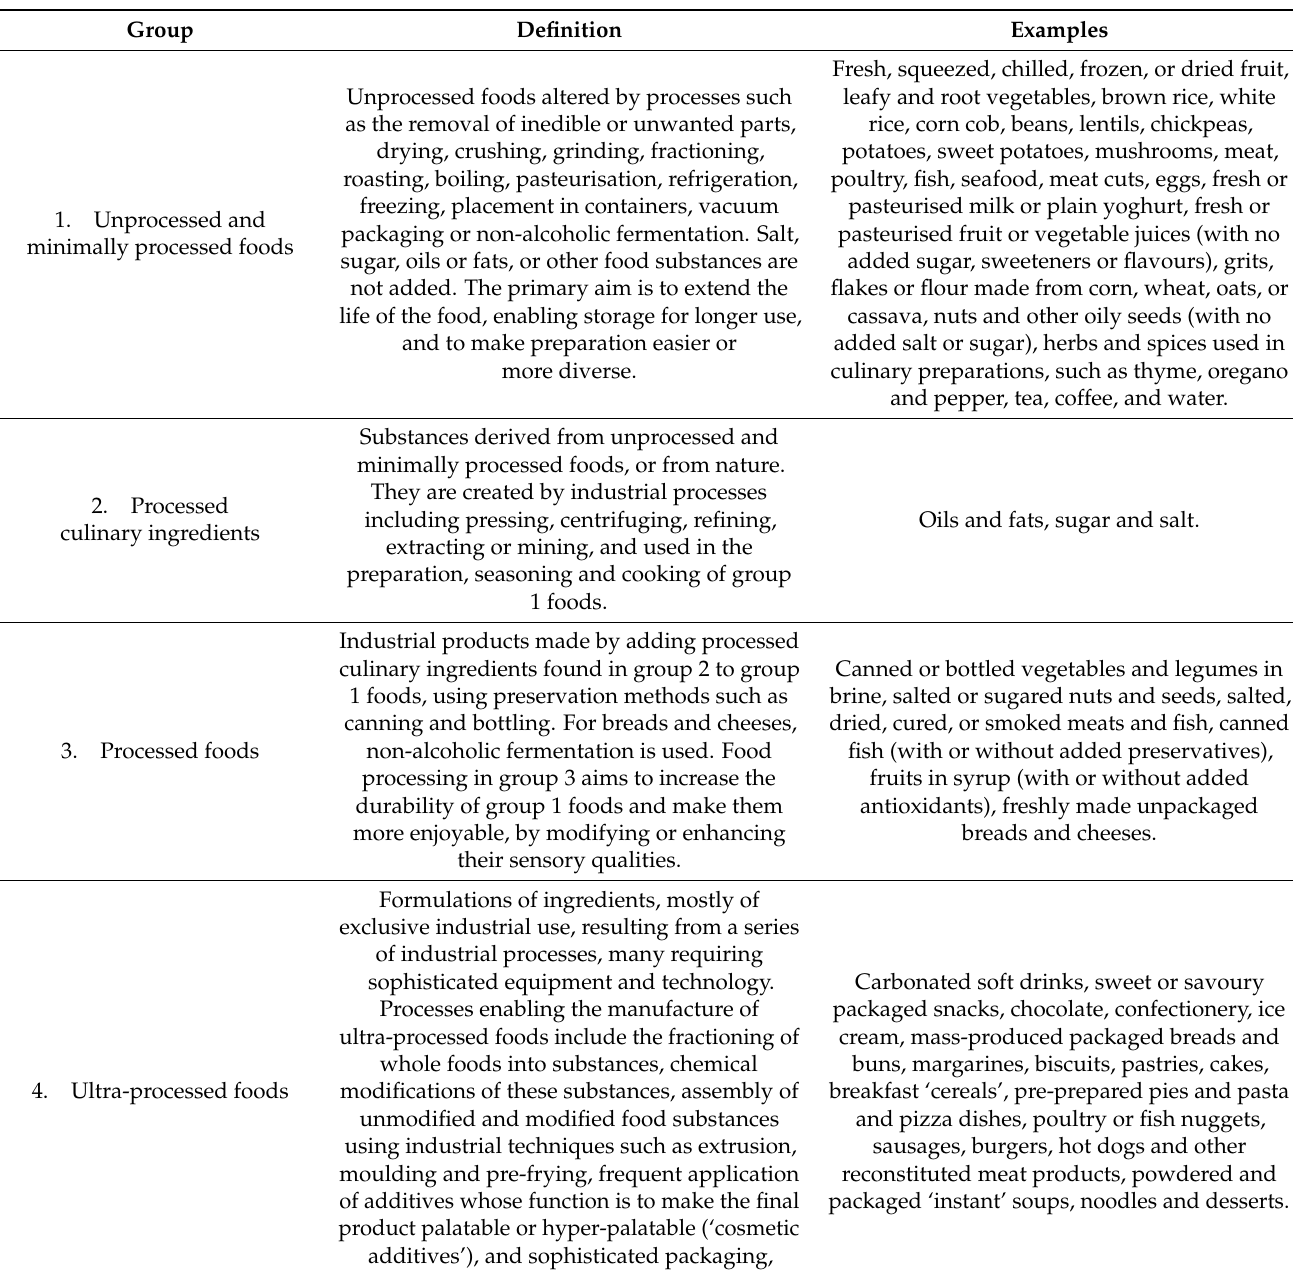
Table 1. Definition of NOVA classifications, from Monteiro et al., 2019